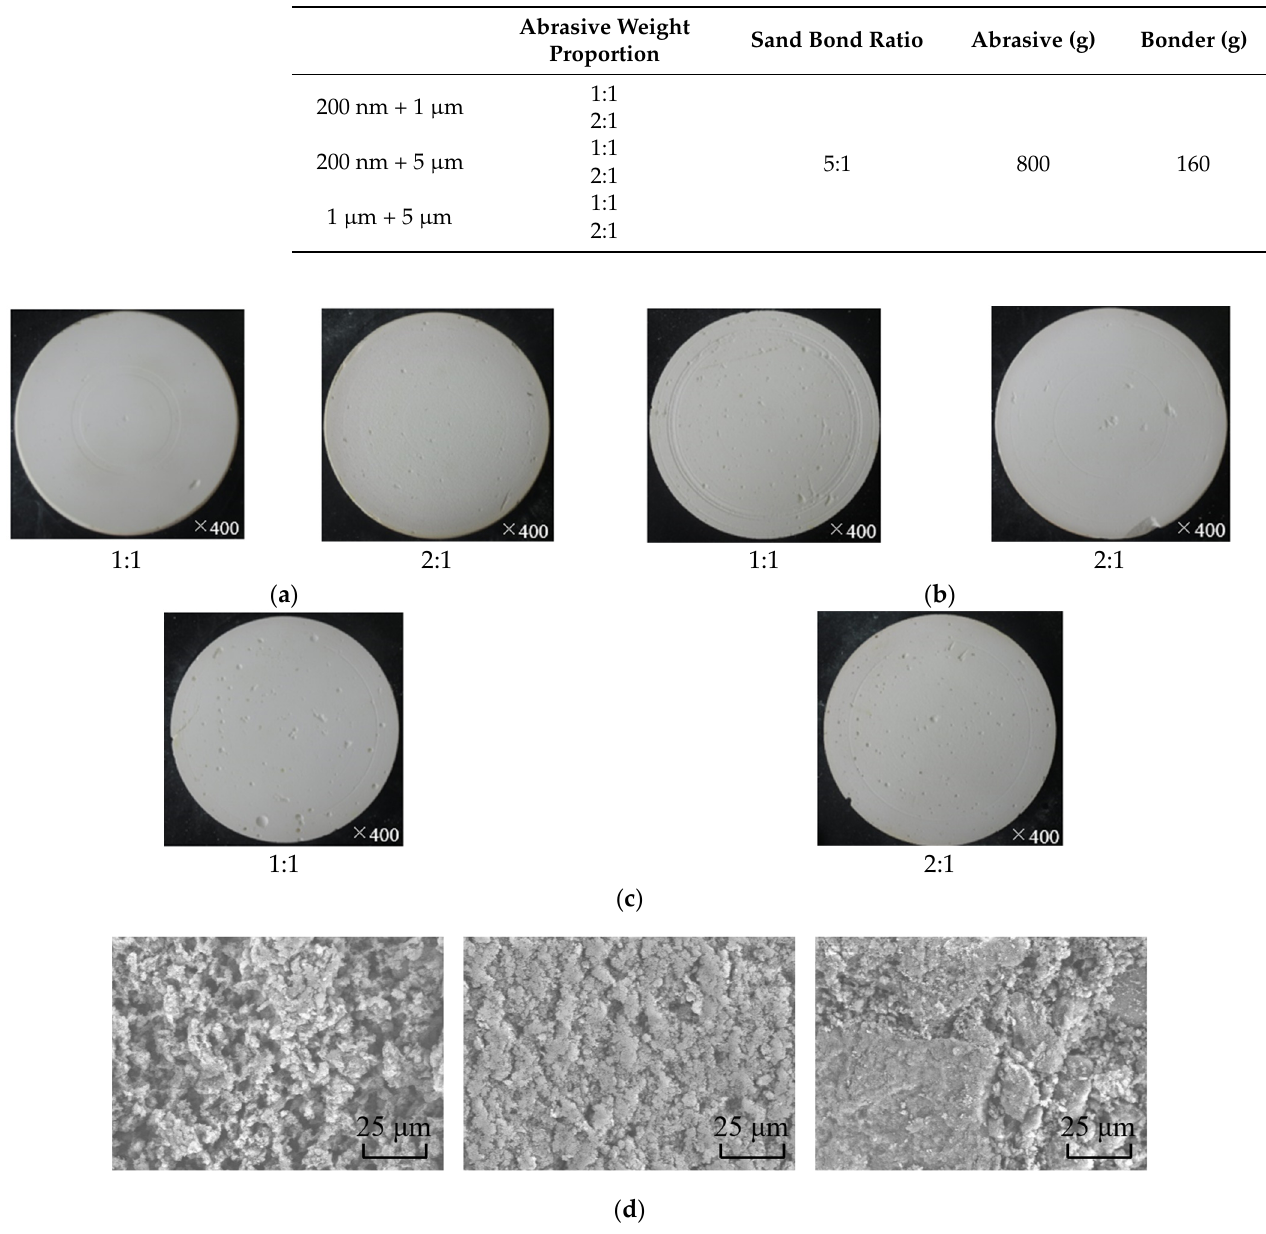
Figure 12. Polishing tool with mixture abrasive particles: ( a ) 200 nm and 1 µ m, ( b ) 200 nm and 5 µ m, ( c ) 1 µ m and 5 µ m and ( d ) surface topography of each polishing tool with 2:1 abrasive weight